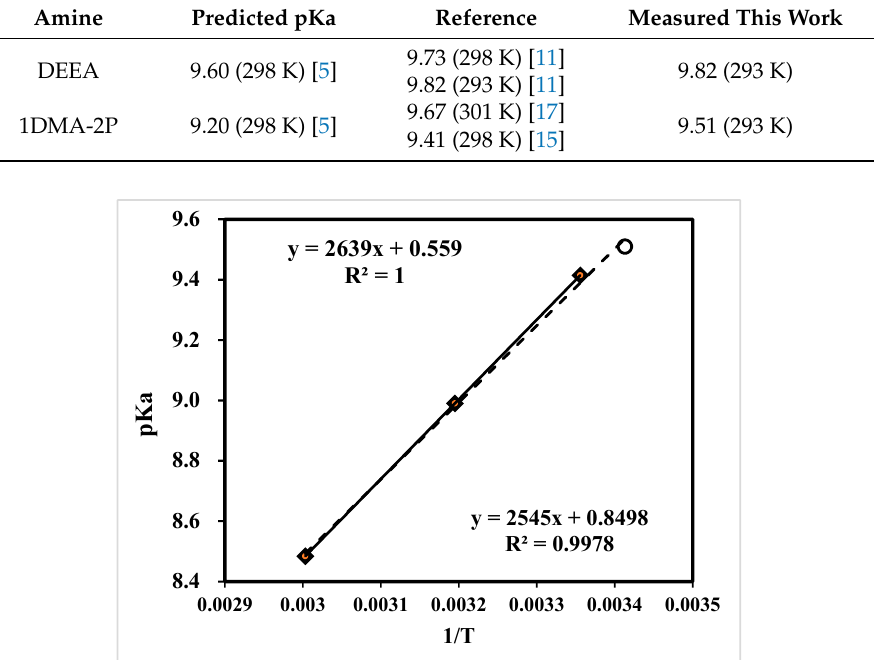
Figure 2. The pKa of 1DMA-2P at 293–333 K and 1 atm a . a The equation above is for the pKa at 298–